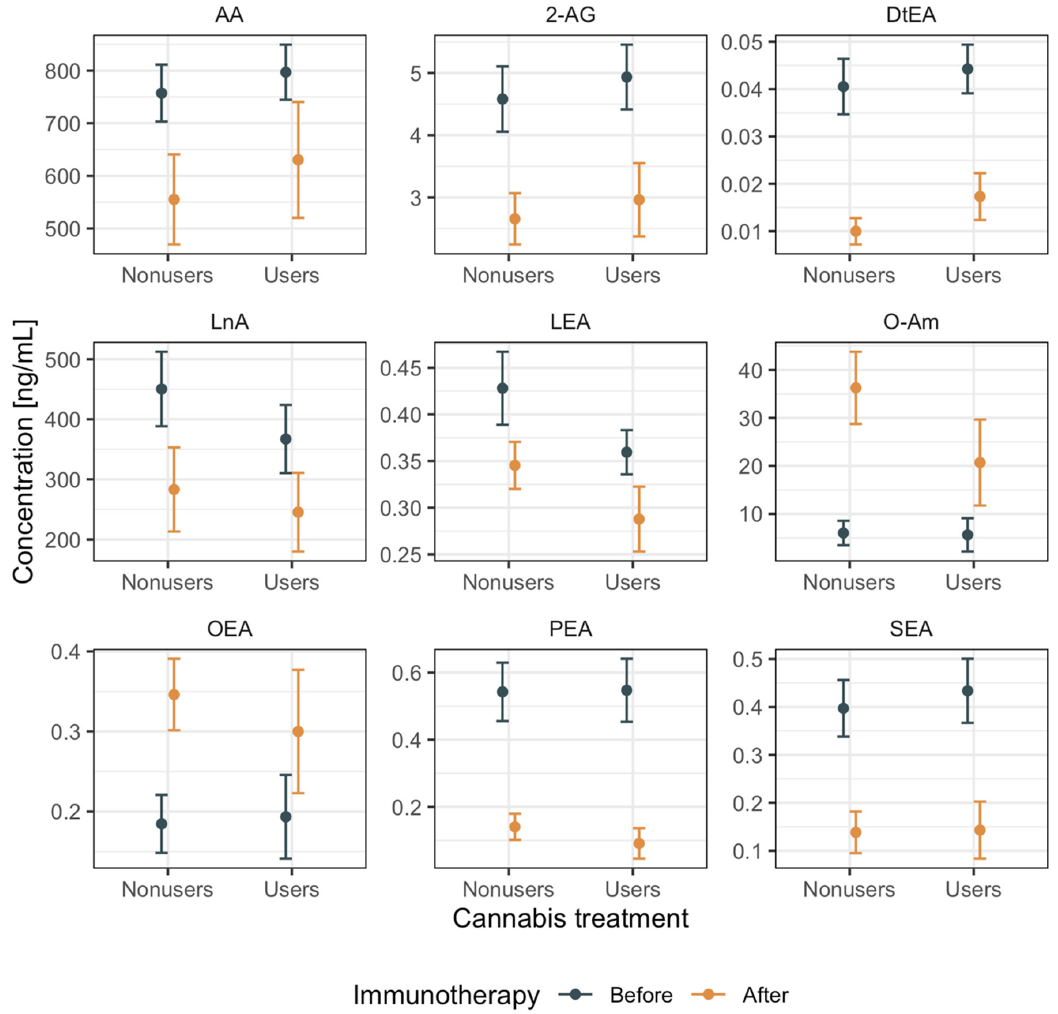
Figure 3. Two-way analysis of endocannabinoid (eCB) and eCB-like lipids variance. Each panel represents a different compound where levels are expressed in (ng/mL) on the y ‐ axis. Dots represent expected values, and lines represent standard error of the mean before and after immunotherapy (grey vs. orange bars) over cannabis users vs. nonusers. Next, we tested whether eCB and eCB ‐ like levels at the baseline (before immunotherapy) were likely to be associated with any significant variation of OS (Figure 4 ) . Four lipids correlated with OS time; in particular, SEA, 2 ‐ AG, and 2 ‐ linoleoyl glycerol (2 ‐ LG) showed an inverse association with